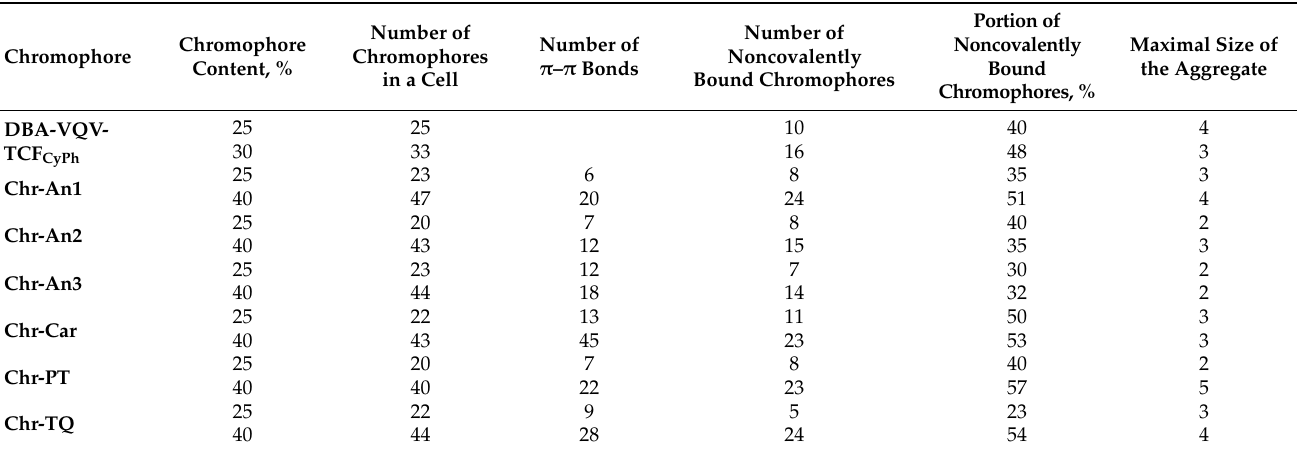
Table 5. Comparison of some characteristics of noncovalently interacting chromophores in PMMA- based composite